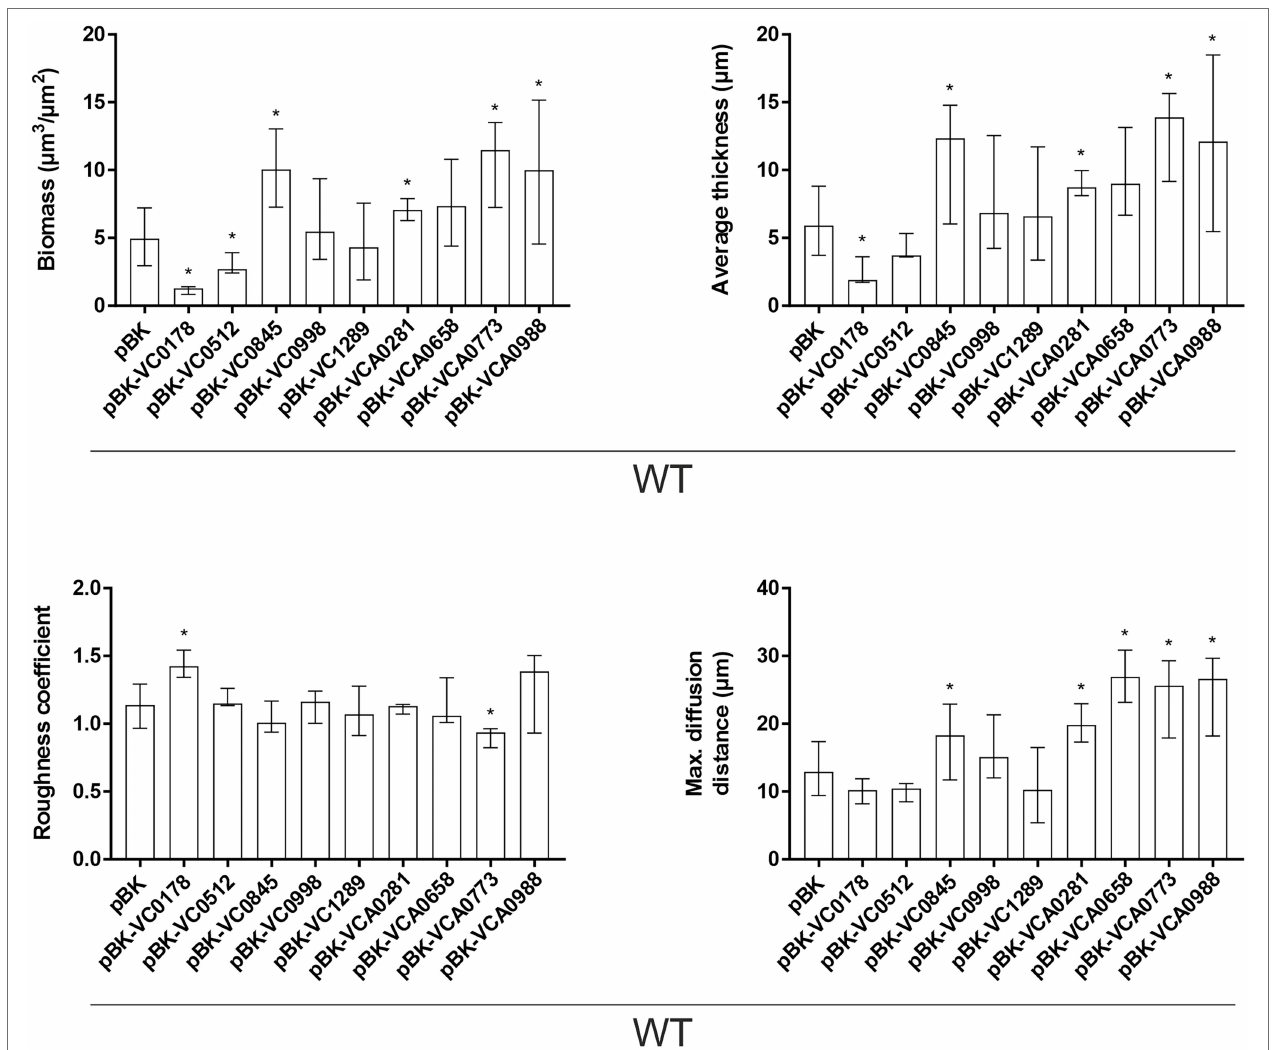
FIGURE 5 | Morphological analysis of biofilms formed by constitutive ibr gene (over)-expression strains and WT with empty vector. Image stacks of WT pBK and WT with expression plasmids were analyzed for the biomass, average thickness, the roughness and maximum diffusion distance using the COMSTAT2 software (http://www.comstat.dk; Heydorn et al., 2000; Vorregaard, 2008). Biofilms were grown for 24 h in flow cell chambers with constant 2% LB medium flow, and then stained with SYTO® 9 before visualizing and processing images. Optical sectioning of the biofilms was performed in 0.5 μ m steps. Representative images are presented in Supplementary Figure S5 . Shown are the medians ± IQR of at least eight image stacks from two independent experiments for each strain. An asterisk indicates a significant difference to WT pBK (* p < 0.05 Kruskal–Wallis test followed by post hoc Dunn’s multiple